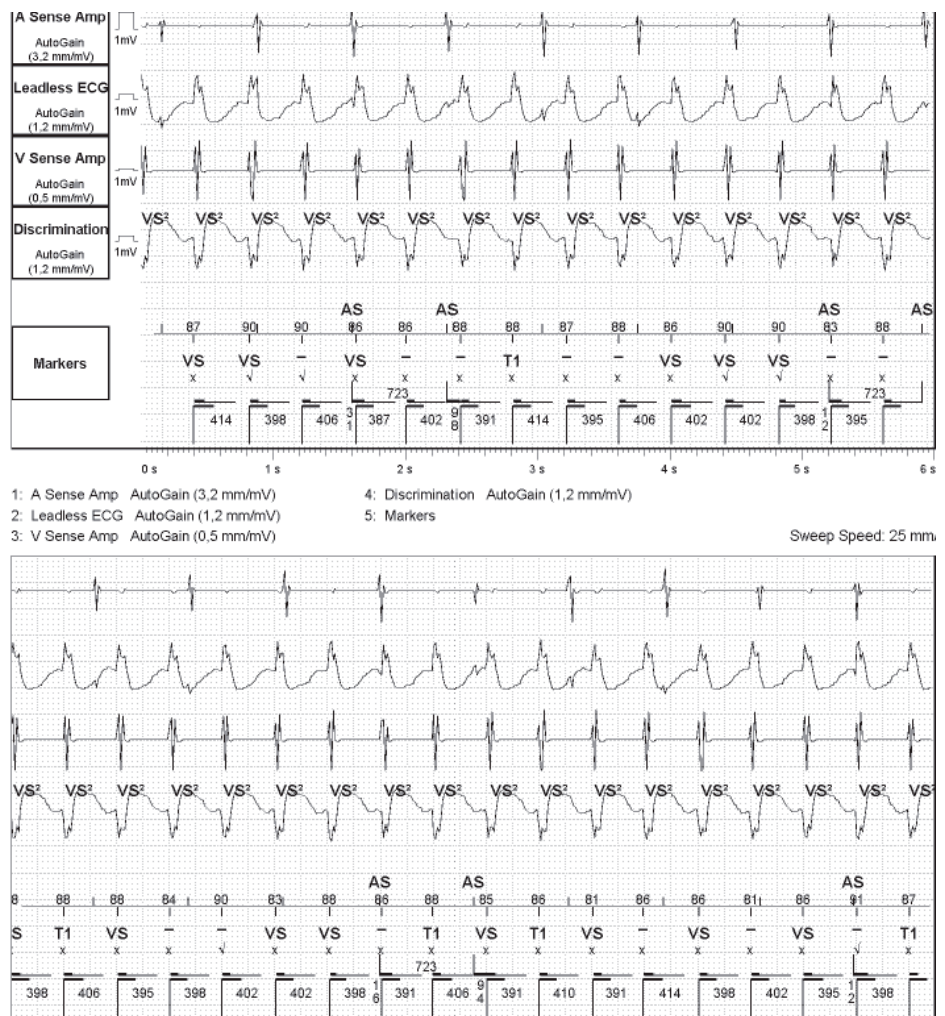
Figure 2. Analysis of implantable cardioverter defibrillator. EGM shows episode of sustained ventricular tachycardia in the VT1-monitoring zone.